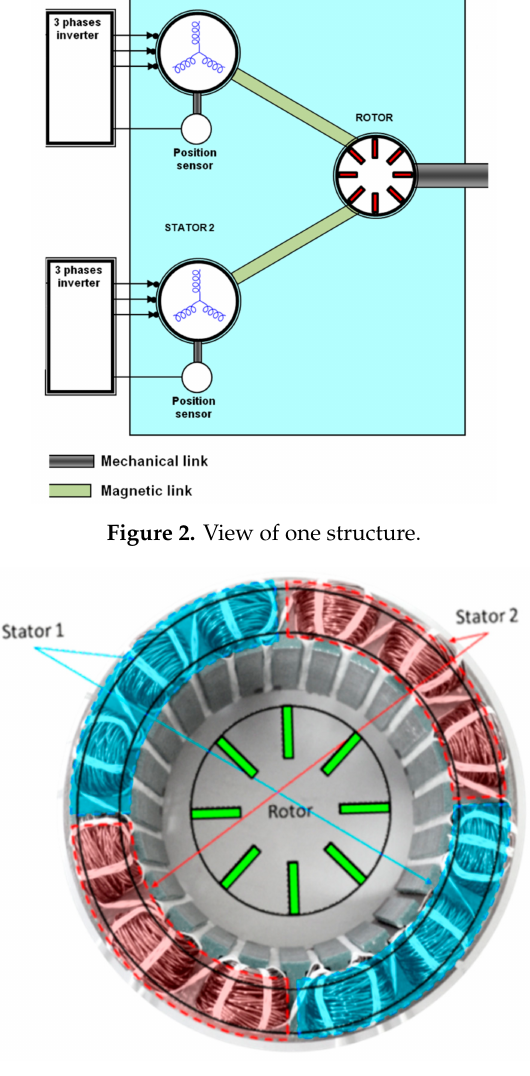
Figure 3. View of the designed stator.